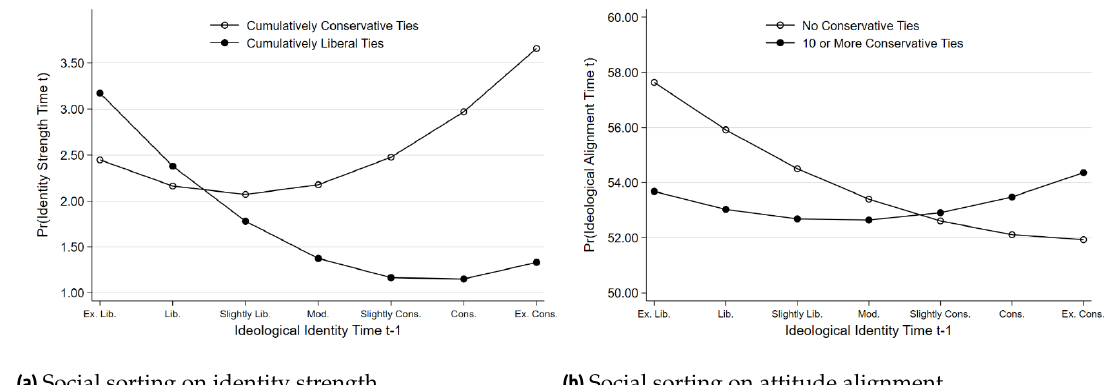
Figure 3: Asymmetric effects of social sorting on subsequent ideological identity strength and attitude align- ment.